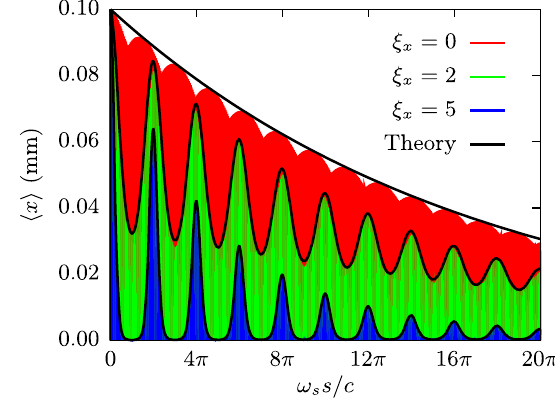
8. Evolution of the dipole moment h x i for three different chromaticities when one includes Fokker-Planck damping and diffusion. The colored lines indicate simulation results using the parameters from Fig. 1, which has ω ≈ 0 . 37 . For this lattice, the nonlinear tune shift with k ξ σ = ξ z x amplitude is negligible at these small oscillation